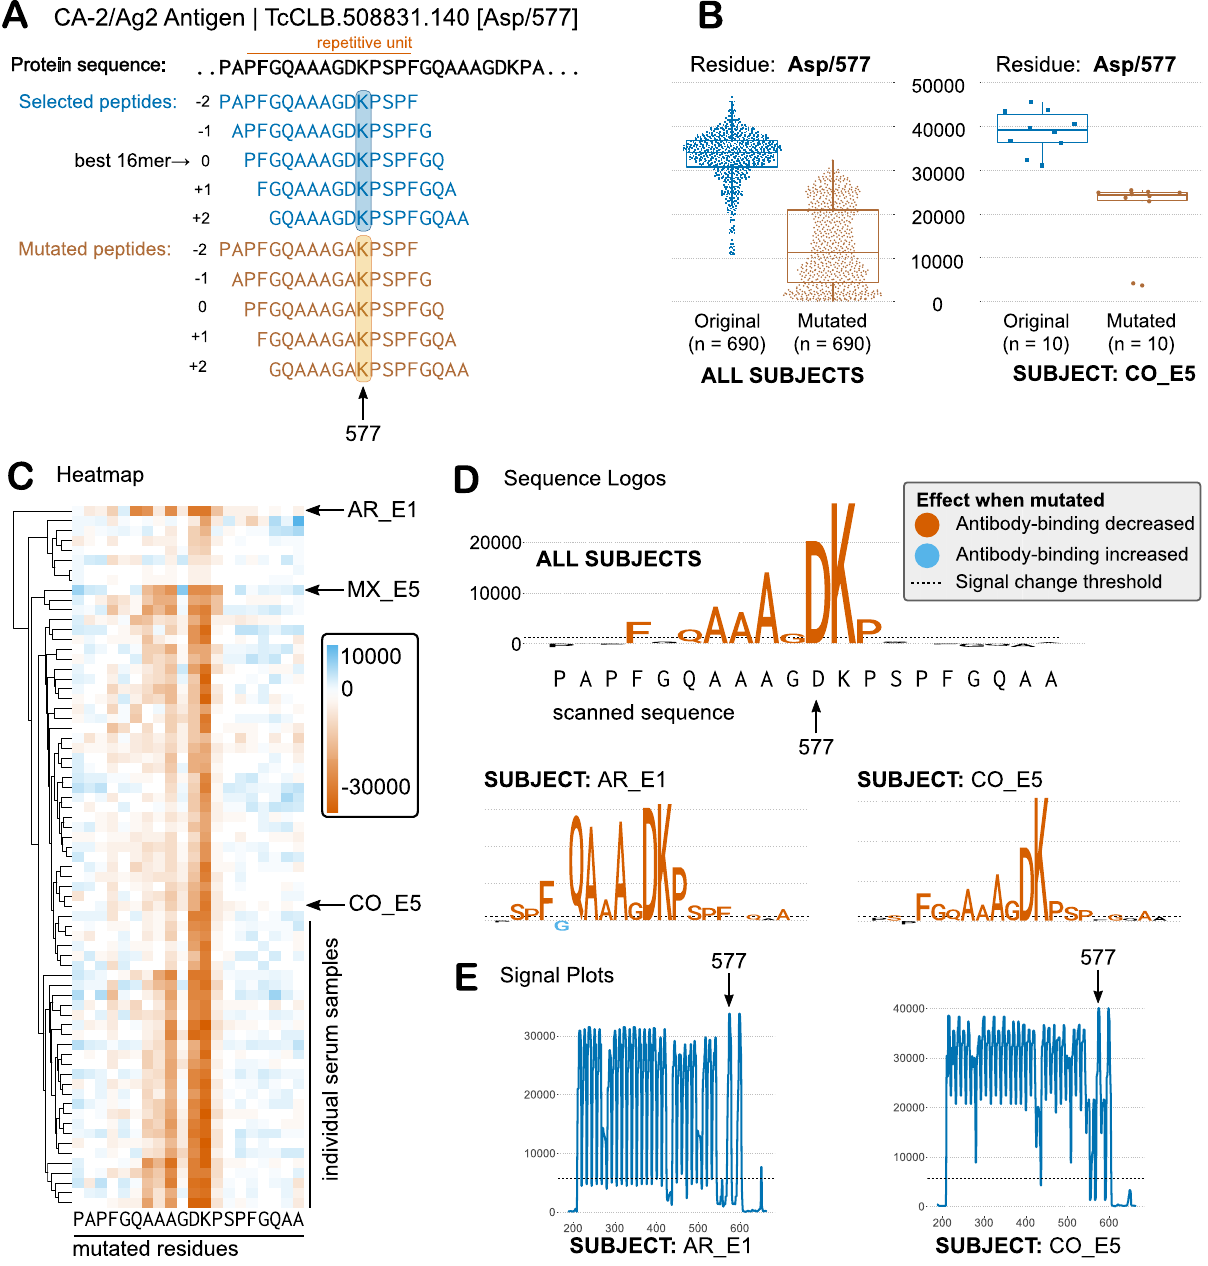
Fig. 7 | Single-residue scanning mutagenesis of T. cruzi antigens. A Schematic representations of single-residue mutagenesis for one repetitive antigen (only 1 residueismutatedinthisdepictionforclarity). B Averagesignaloftheoriginaland mutated peptides for the Asp/577 residue for all positive sera ( n =69 biological independent samples) for this antigen (left) and for one selected subject (right). Each point represents the signal from an independent experiment, e.g., a peptide that contains residue 577 either as Asp (wild-type) or Ala (mutated). Boxplots: the upper and lower bounds of the box correspond to the fi rst and third quartiles. Whiskersextendfromtheboxupto1.5×IQR(interquartilerange)ortothesmallest